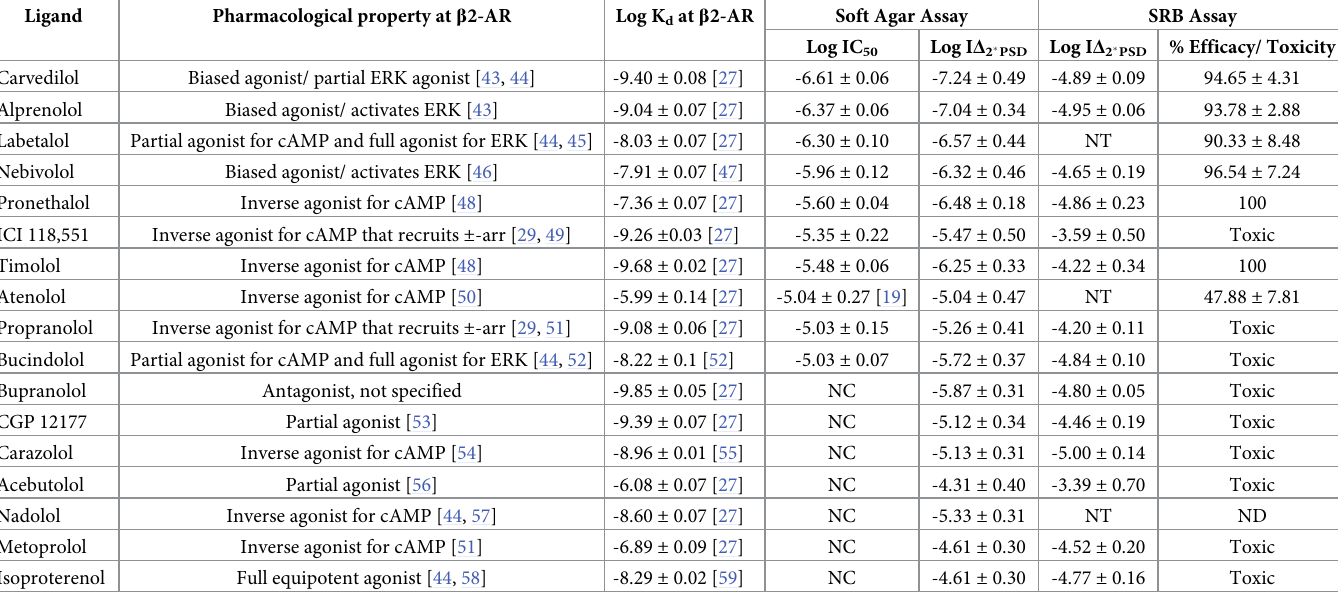
Table 1. Quantification and analysis of concentration-response curves of β -AR